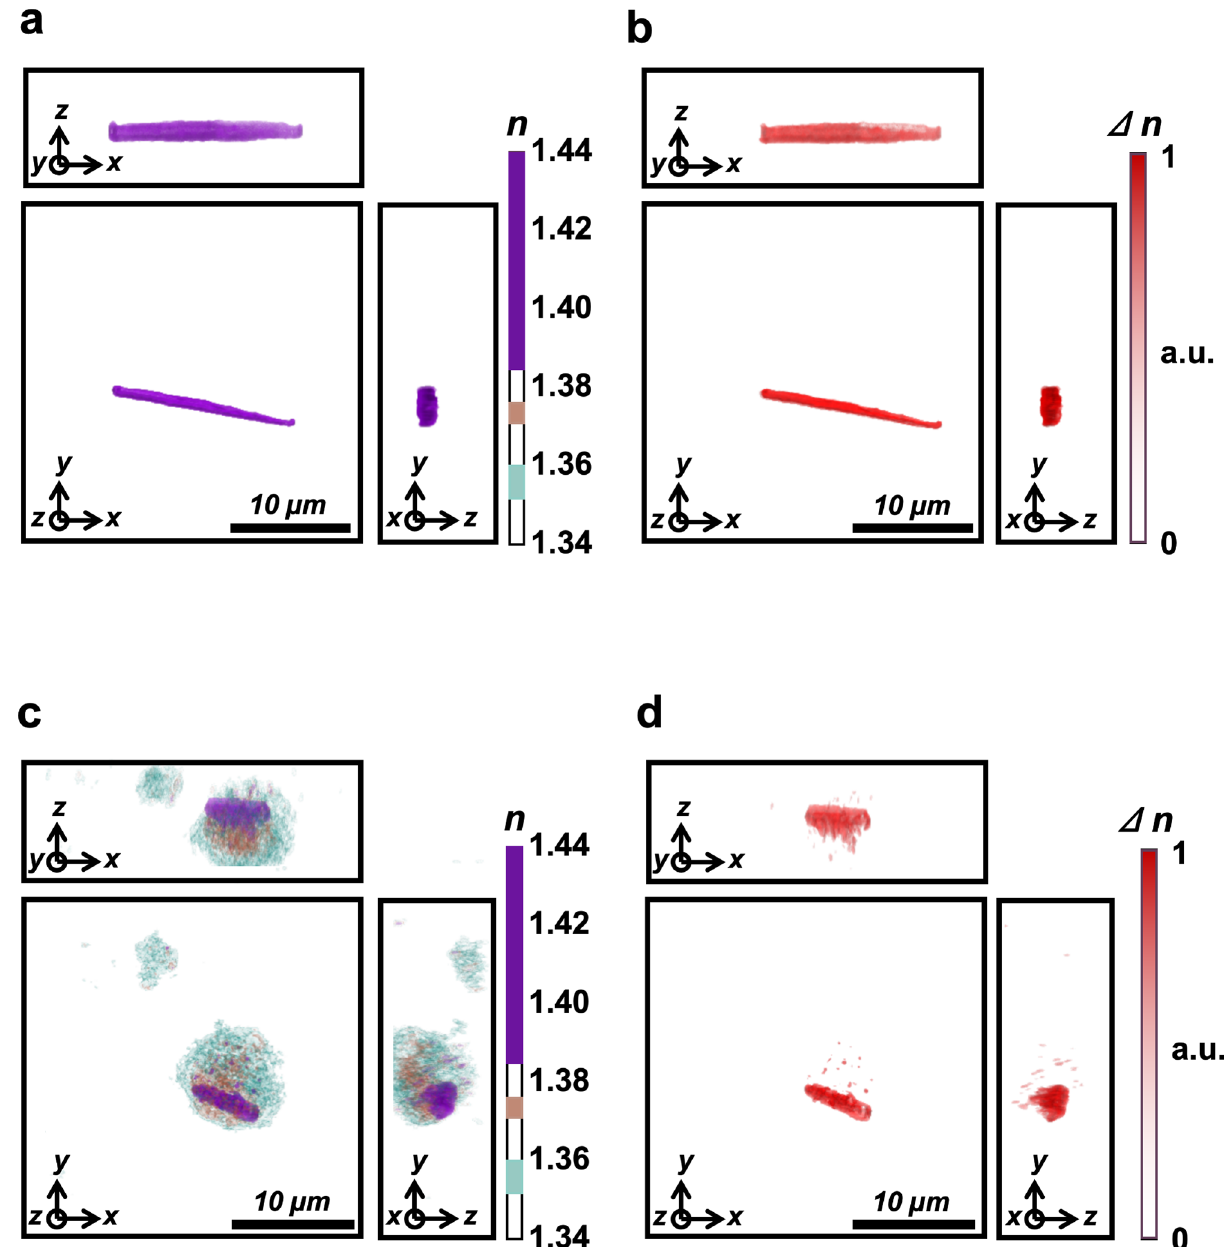
Figure 4. Birefringence properties of patient monosodium urate (MSU) crystals and polarization-sensitive RI contrast tomogram. ( a ) A three-dimensional (3D) holotomographic image of synthetic MSU crystals under a polarized light source with a 0° angle. ( b ) Polarization contrast image of MSU crystals under a polarizing filter used during optical diffraction tomography (ODT) with a 90° angle. ( c ) 3D holotomographic image of synovial mononuclear cells. Intracellular MSU crystal is distinguished by its relatively higher RI value, as shown in previous figures. ( d ) Polarization contrast image of MSU crystal-containing synovial mononuclear cells, obtained under a polarizing filter in ODT with a 90° angle. In this image, all structures without birefringence disappeared, and the remaining MSU crystal was shown in red color. n: refractive index, ∆n: change of refractive index under the two different polarizing filter